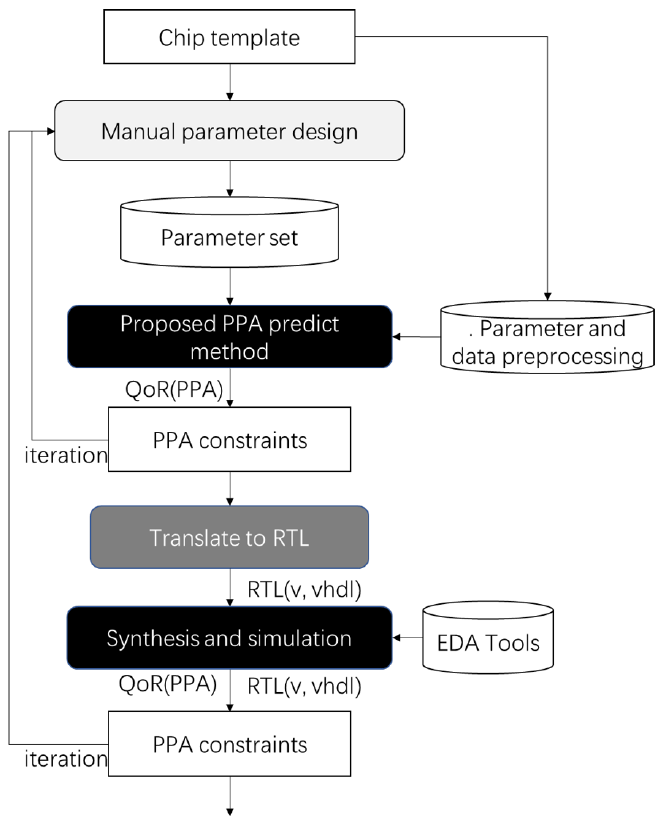
Figure 2. The parameter design process with proposed PPA prediction